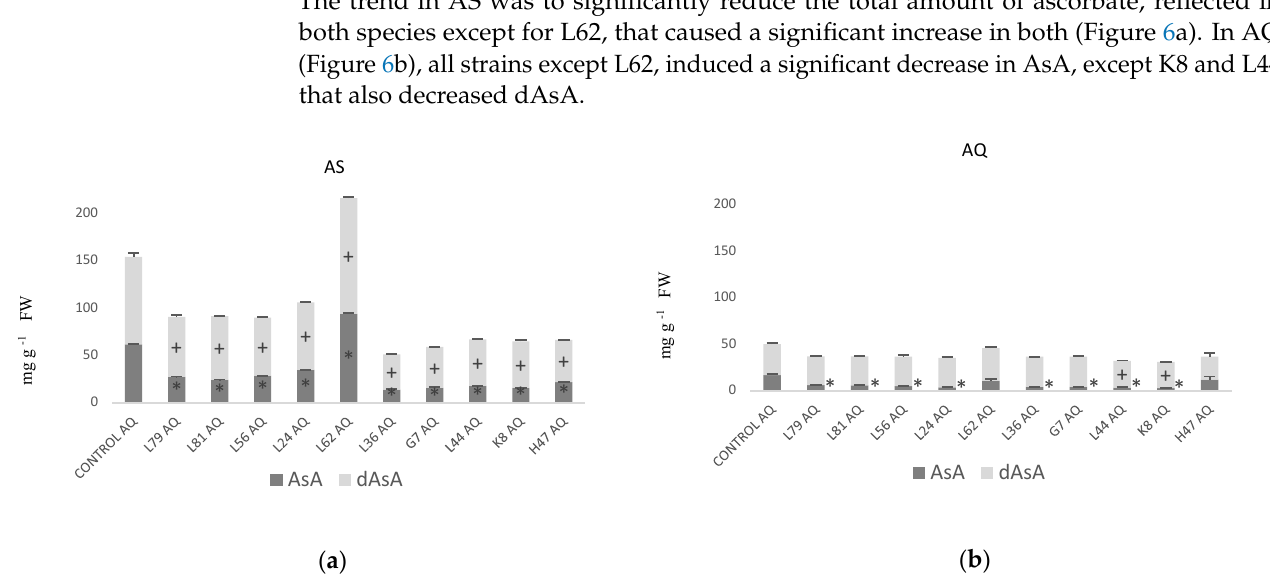
Figure 6. Ascorbate concentration (mg g − 1 FW) in the oxidized (dAsA) and reduced (AsA) forms in leaves of ( a ) AS and ( b ) AQ, in plants inoculated with the 10 PGPB and the non-inoculated controls. Values are the average ± SE (n = 3). Asterisks (*) or (+) indicate significant differences with the controls according to t student ( p < 0.05) for AsA, and dAsA, respectively. Glutathione (Figure 7) is less abundant in AQ than AS, mainly due to the lower concentration of reduced glutathione (GSH) in AQ (Table 1). In AS, the general trend was to significantly increase glutathione, mainly in the oxidized pool, being especially effective L62, G7 and L44; conversely, some strains (L79, L56, L24, L36, H47) significantly decreased GSH. In AQ (Figure 7b), the glutathione pool is significantly increased by L79, L24, L36 and K8, due to increases in GSH, except for L36 that increases both GSH and GSSG; however, strains L81 and G7 modified the balance GSH/GSSG, significantly decreasing